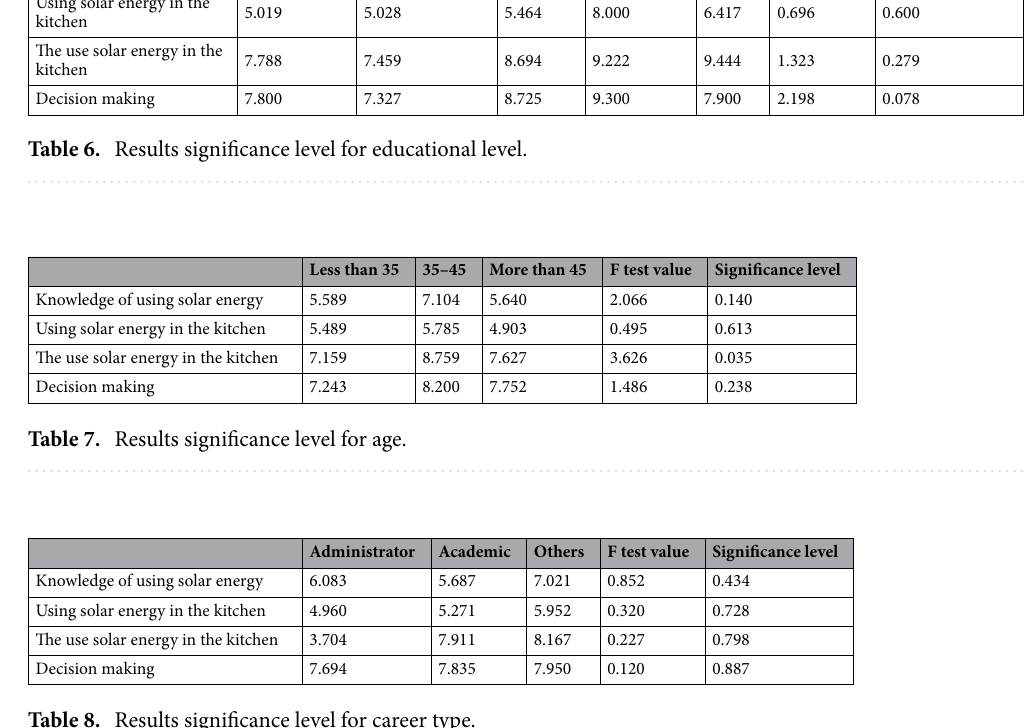
Table 8. Results significance level for career